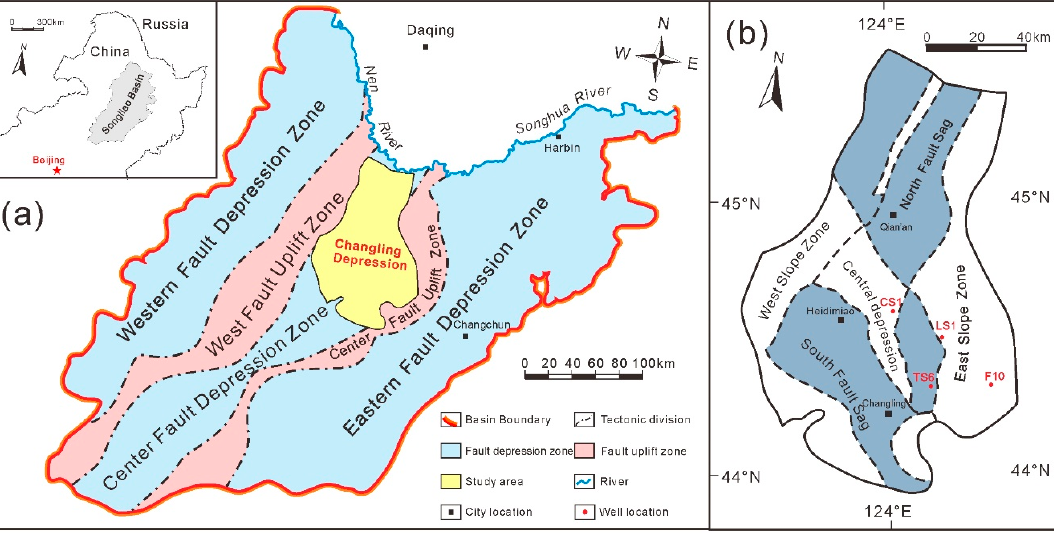
Figure 1. Location and geographic setting of the study area. ( a ) General location map, with the borders and tectonic divisions of the Songliao Basin and Changling Depression modified after Chen et al. [13]. ( b ) Major structures and well locations in the Changling Depression.